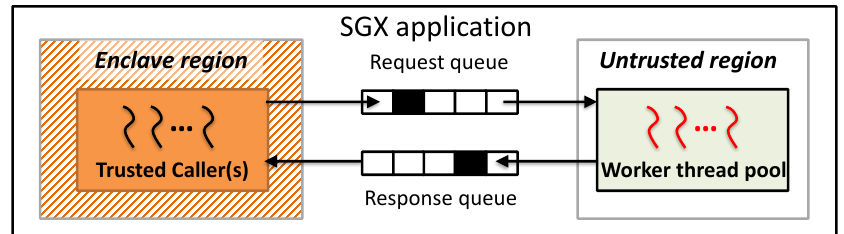
Figure 1. Work flow of switchless